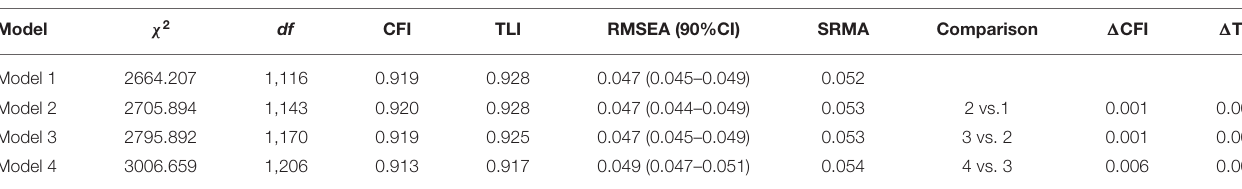
TABLE 7 | Measurement invariance of the CERQ-C across gender.